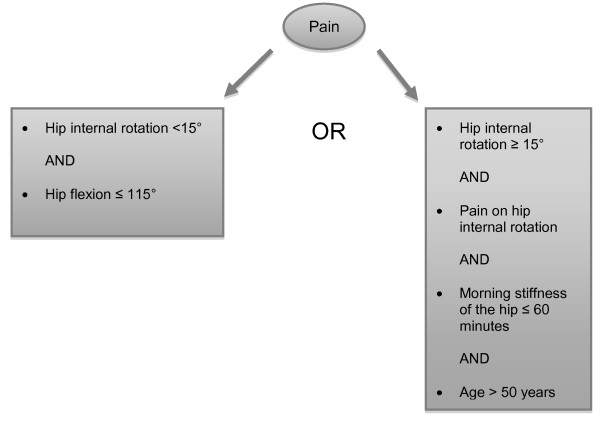
Clinical ACR criteria Hip.